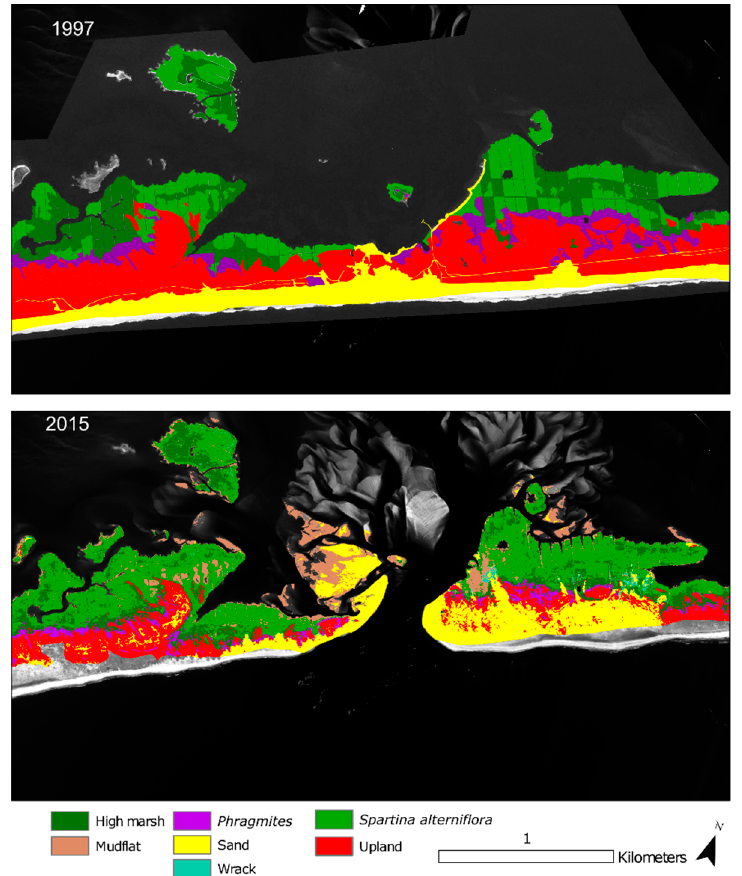
Figure 8. Land cover of the area surrounding the 2012 Fire Island breach for 1997 and 2015. Land cover change both due to the breach and overwash are evident in the 2015 classification. Spartina alterniflora classes are shown as a single class due to the 1997 class no differentiating between percent cover. Upland and dune vegetation classes are also shown as a single class.